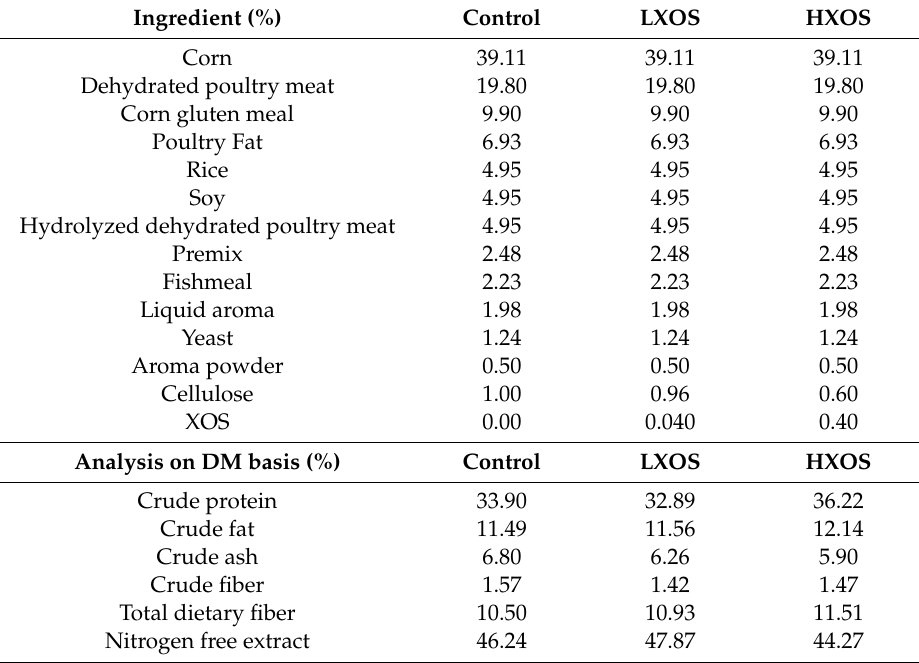
Table 3. Ingredients and macronutrient composition of control and experimental